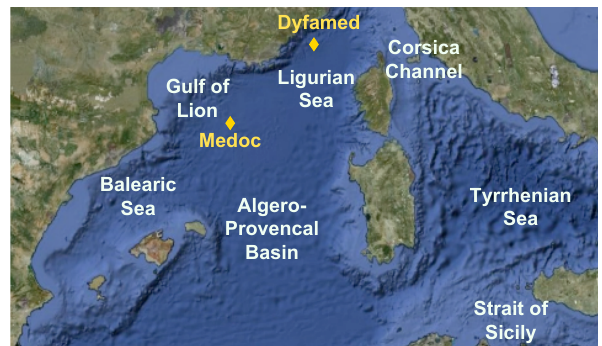
Fig. 1. Satellite view of the Mediterranean Sea. Modified from maps.google.com.